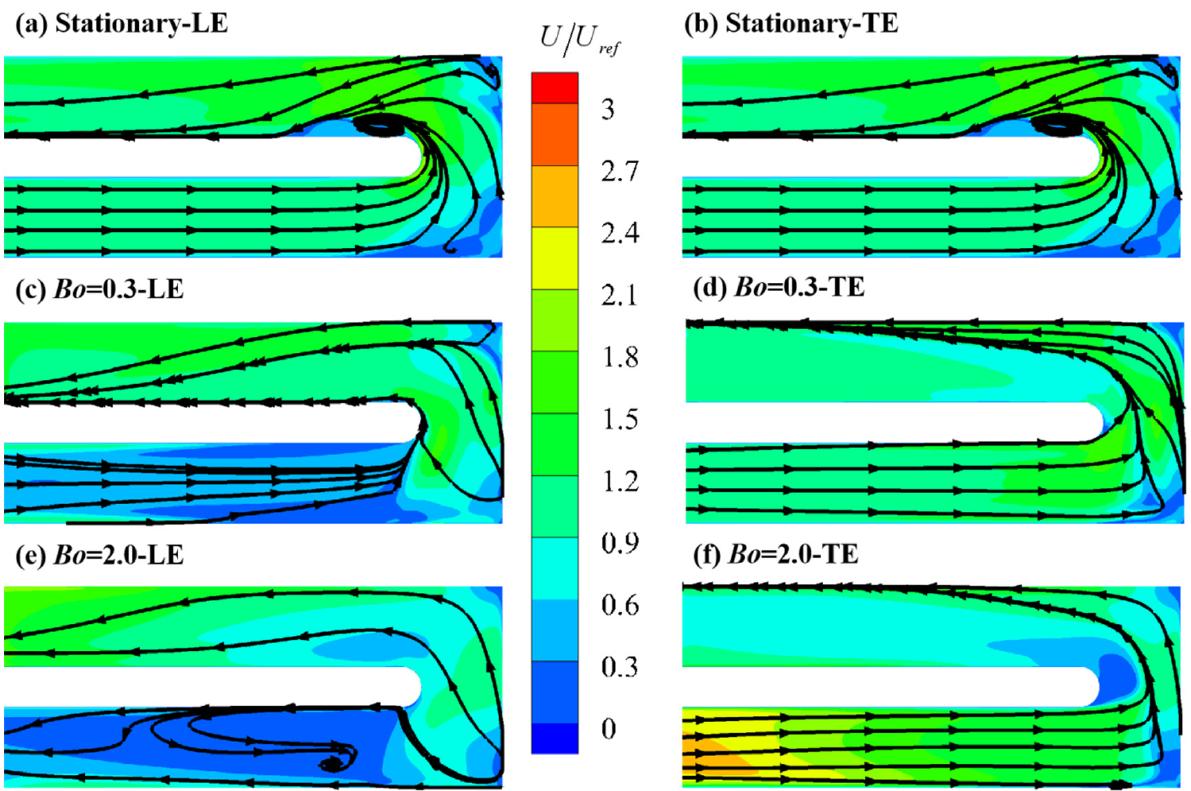
Figure 6. 2-D non-dimensional velocity ( U / U ref ) contour and streamline in meridian planes at Z / H = 0.9 (near LE) and 0.1 (near TE) of smooth channel.